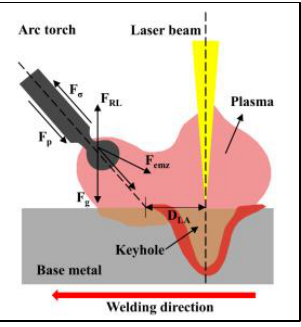
Figure 7. Schematic diagram of hybrid welding droplet force.